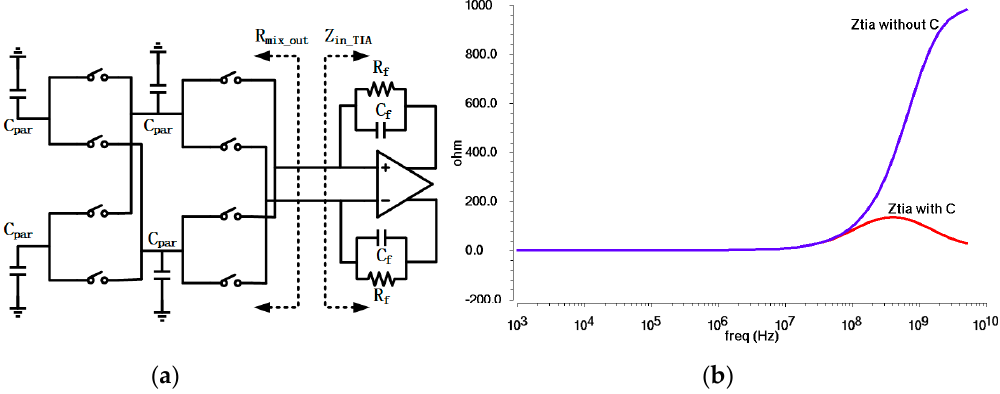
Figure 13. ( a ) Output and input impedance of the SHM and TIA; and ( b ) simulation results of the input